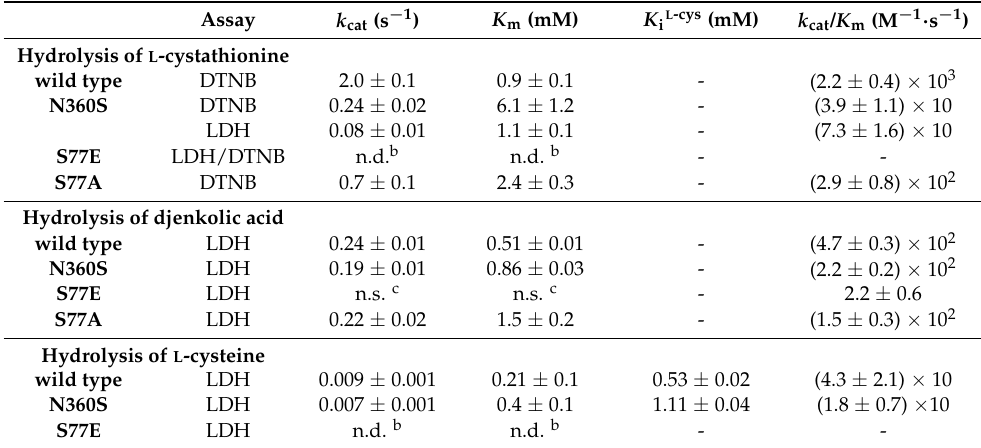
Table 1. Steady-state kinetic parameters of TgCGL variants a at pH 9 and 37 ◦ C.